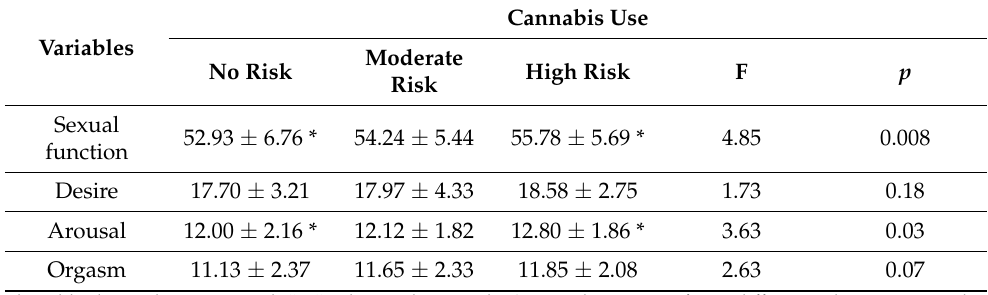
Table 4. The relationship between cannabis use and sexual function according to categories.